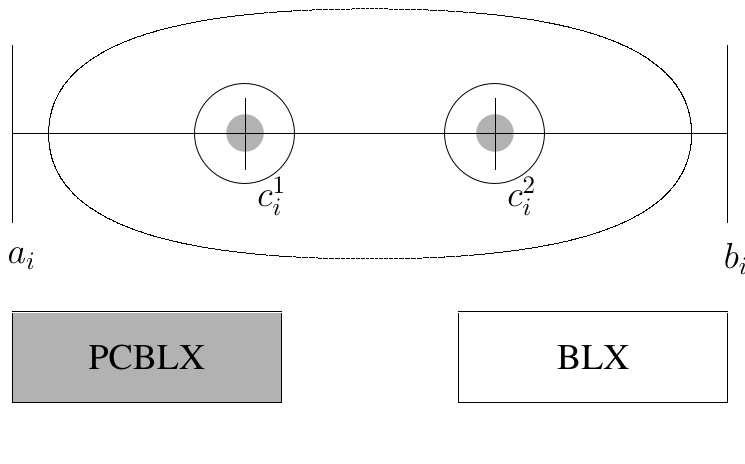
Figure 2. Scheme of the behaviour of the BLX and PCBLX